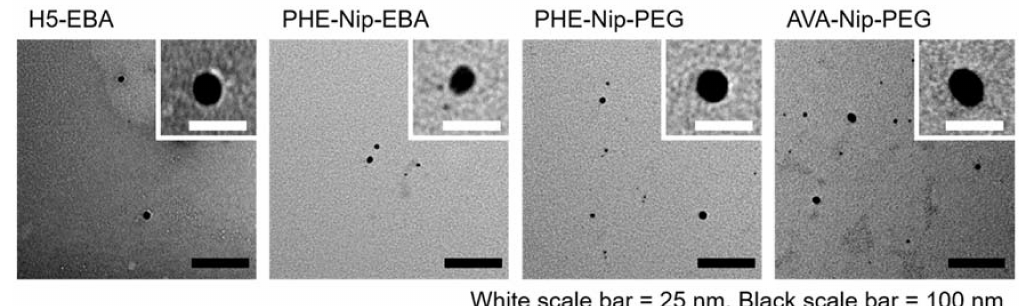
Figure 7. TEM images of the silver nanocomposite hydrogels: H5-EBA, PHE-Nip-EBA, PHE-Nip-PEG, and